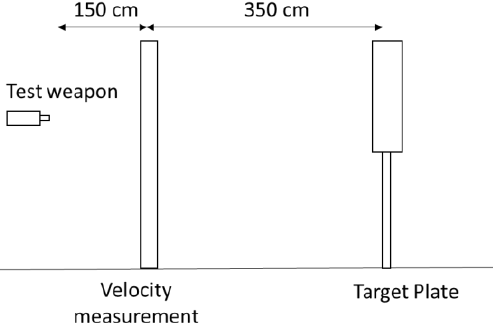
Figure 3. The schematic of the ballistic test system used.